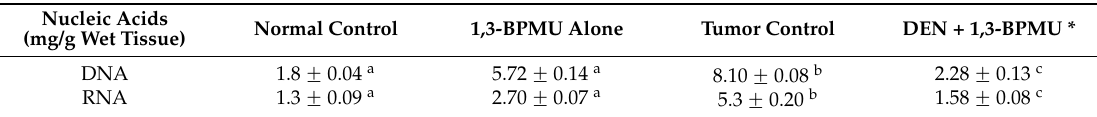
Table 3. Effect of 1,3-BPMU on the levels of nucleic acids in livers of control and experimental groups of rats.